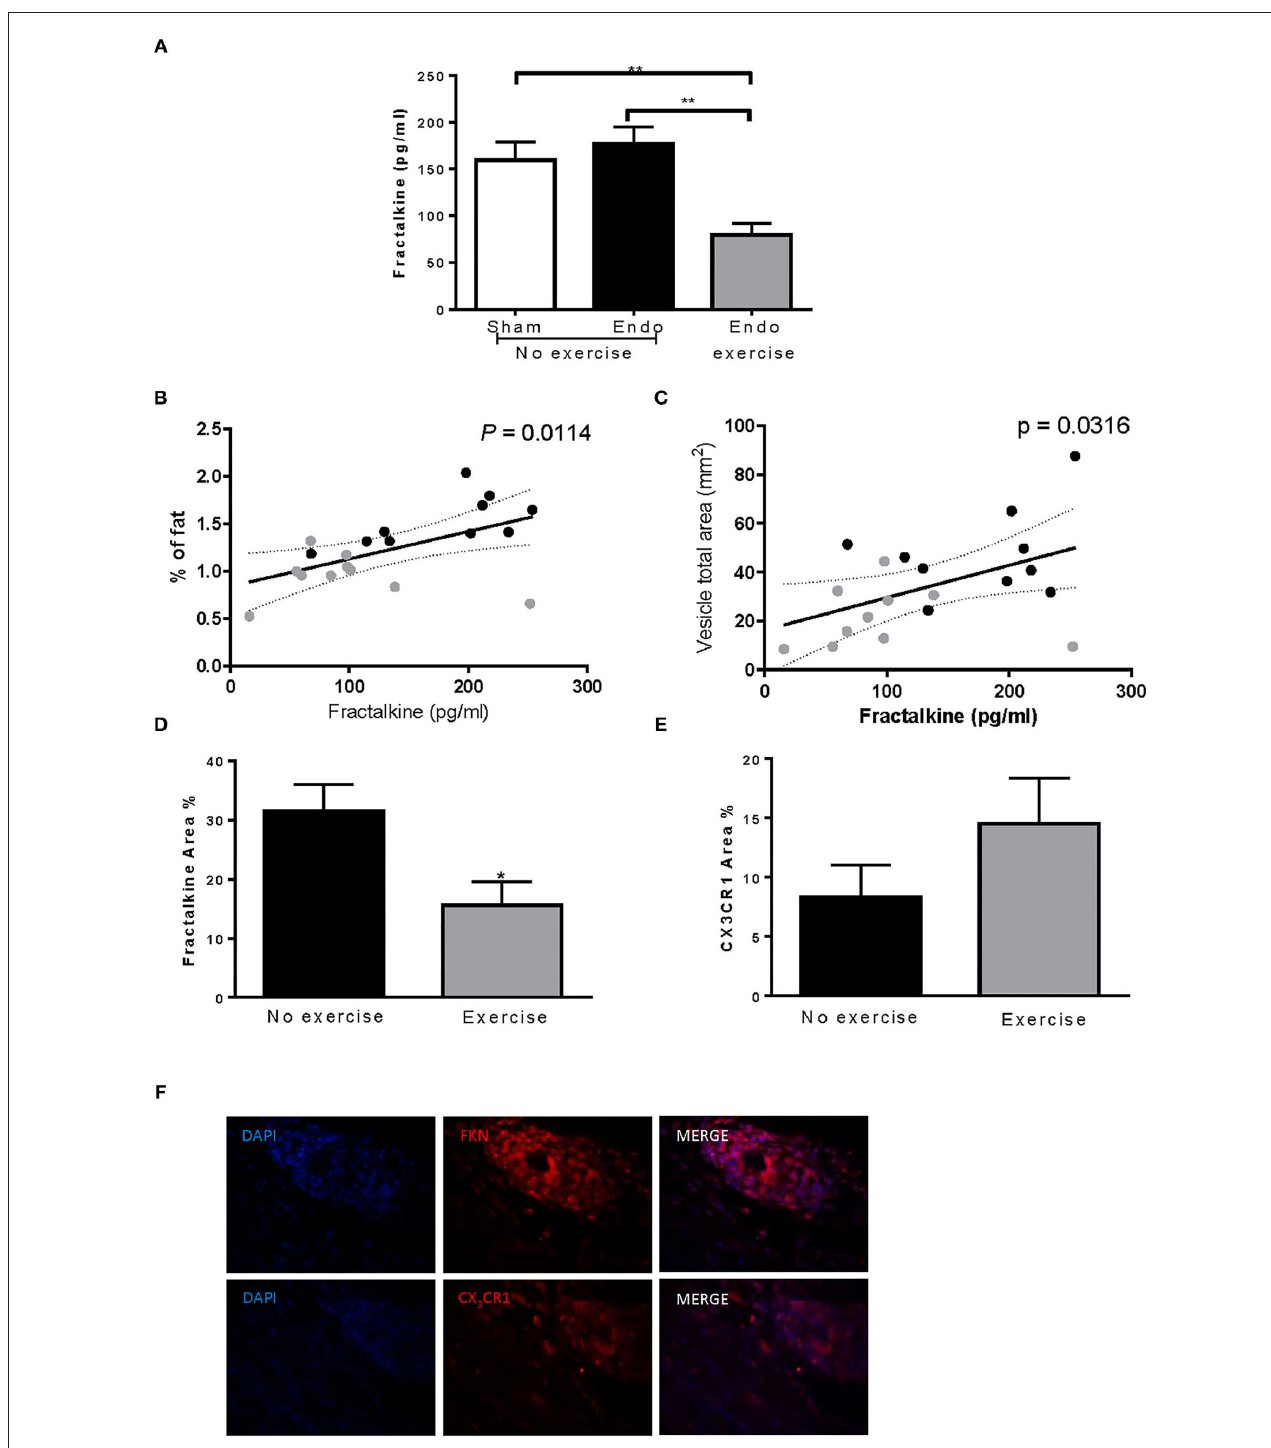
FIGURE 5 | Exercise decreased fractalkine levels in endometriosis. (A) Exercise significantly reduced serum levels of fractalkine in endometriosis animals. Increased serum fractalkine levels in endometriosis animals correlated with (B) increased % fat and (C) larger vesicle size. (D) Fractalkine expression in vesicles from Endo-Exercise animals was significantly less compared to Endo-No Exercise. (E) CX3CR1 percent area almost doubled in Endo-Exercise but did not reach significance. (F) Representative immunofluorescence pictures of endometriotic tissue expressing fractalkine (FKN) or CXC 3 R1 (red), with nuclei counterstaining (DAPI; blue) at 100x magnification ( n = 9–10 animals/group ± sem; * p < 0.05, ** p < 0.01; black circles represent Endo-No exercise, gray circles represent Endo-Exercise).